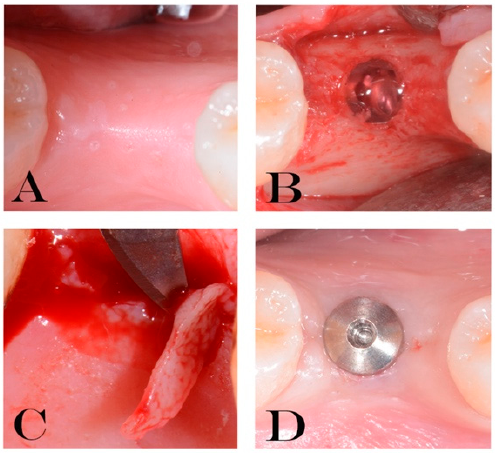
Figure 2. Explanatory images of the treatment performed ( A – D ). ( A ) residual crest. ( B ) gel inserted into the fixture (T0). ( C ) soft tissue biopsy (T1). ( D ) healing abutment placed (T1).